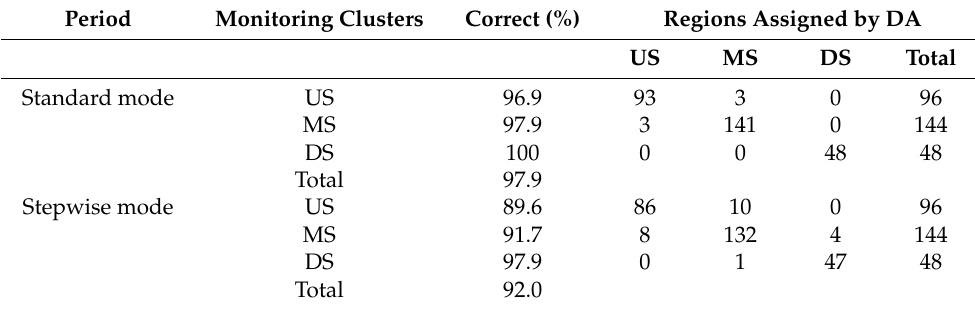
Table 8. Classification matrix for the discriminant analysis of spatial